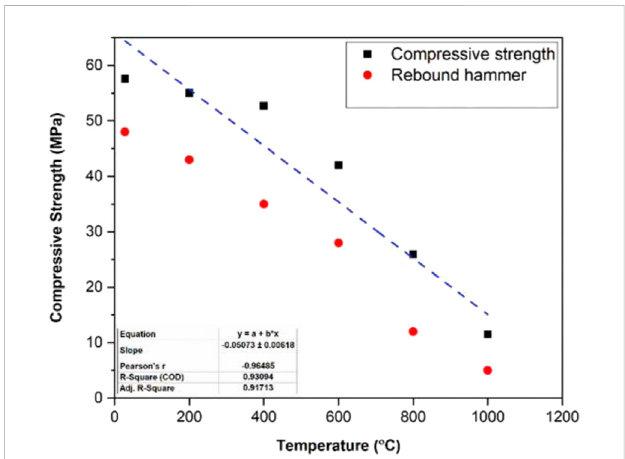
FIGURE 12 Correlation curve between compressive strength and rebound hammer for DC3